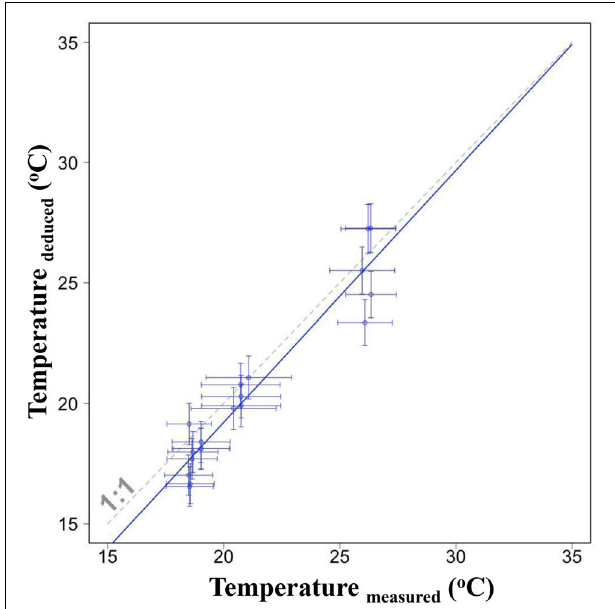
FIGURE 6 | The linear relationship between deduced temperatures from δ 18 O values of individual statolith edges and corresponding measured temperatures in the same period. Horizontal error bars indicate one standard deviation of measured temperature; vertical error bars indicate one standard deviation evaluated by using Monte Carlo Simulations and considering uncertainty caused from salinity and parameter variation in the equation. Dashed line indicates the 1:1